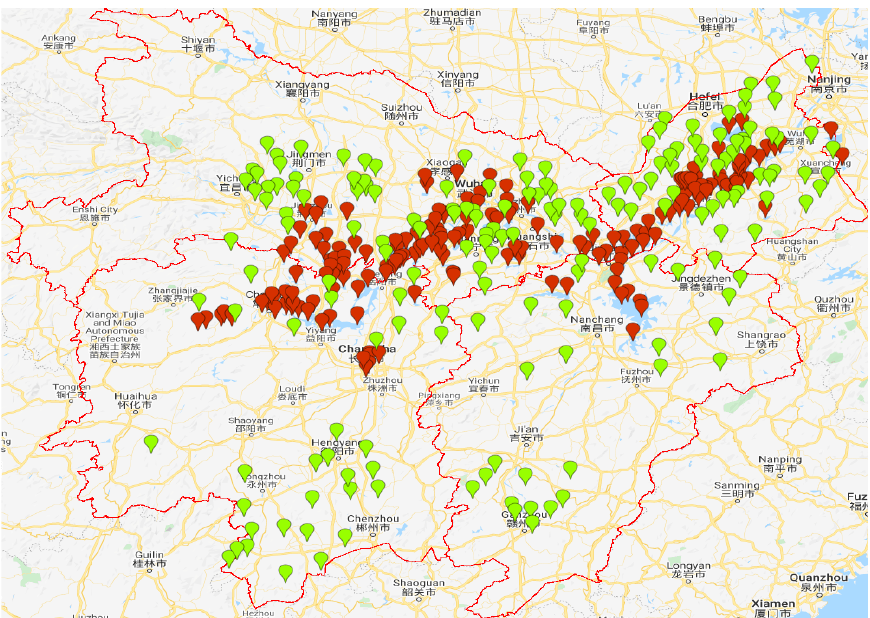
Figure 7. Training samples: 172 points for water body and 172 points for cropland.